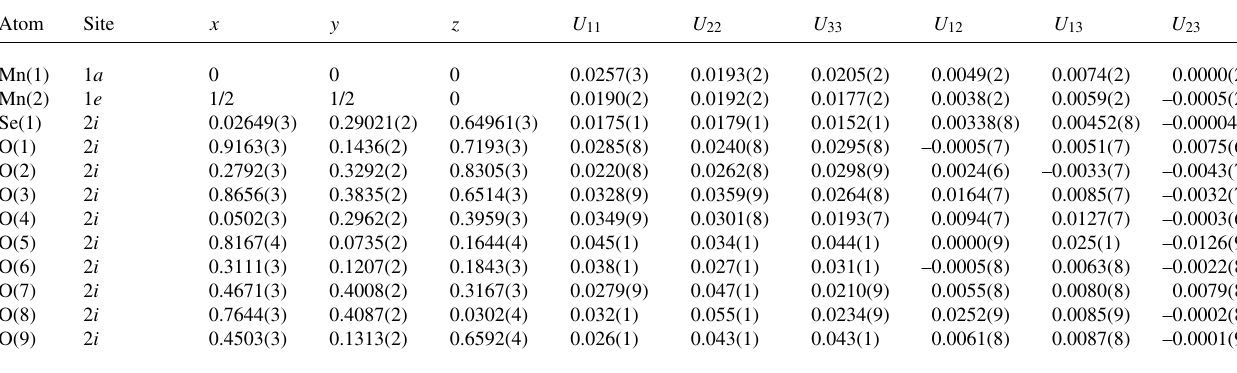
Table 3. Atomic coordinates and displacement parameters (in Å 2 )